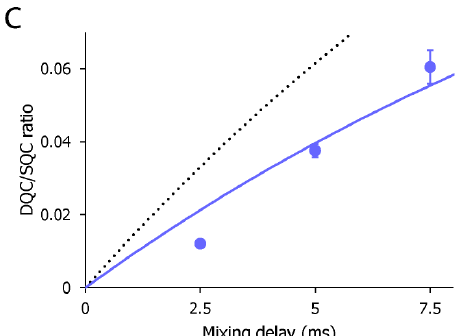
Figure 3. The CF 3 –FCT data of AST-487 complexed with p38 α . ( a ) Overlay of the 19 F–1D spectra of AST-487 in the presence (red) and absence (black) of perdeuterated p38 α ; ( b ) Spectral regions of the CF 3 resonance of AST-487 bound to perdeuterated p38 α (upper) and those in the absence of p38 α (lower) in the 19 F–DQC (double quantum coherence) spectra at mixing times of 2.5, 5 and 7.5 ms; ( c ) The time-dependent evolution of the I DQC / I SQC ratio. Error bars are estimated from the signal-to-noise ratios. The fitting curve is drawn as a solid line. For comparison, a simulated curve with (cid:1845) (cid:3028)(cid:3051)(cid:3036)(cid:3046)(cid:2870) = 1 ( δ = − 29 s − 1 ) is shown as a dotted line. SQC: single quantum coherence.